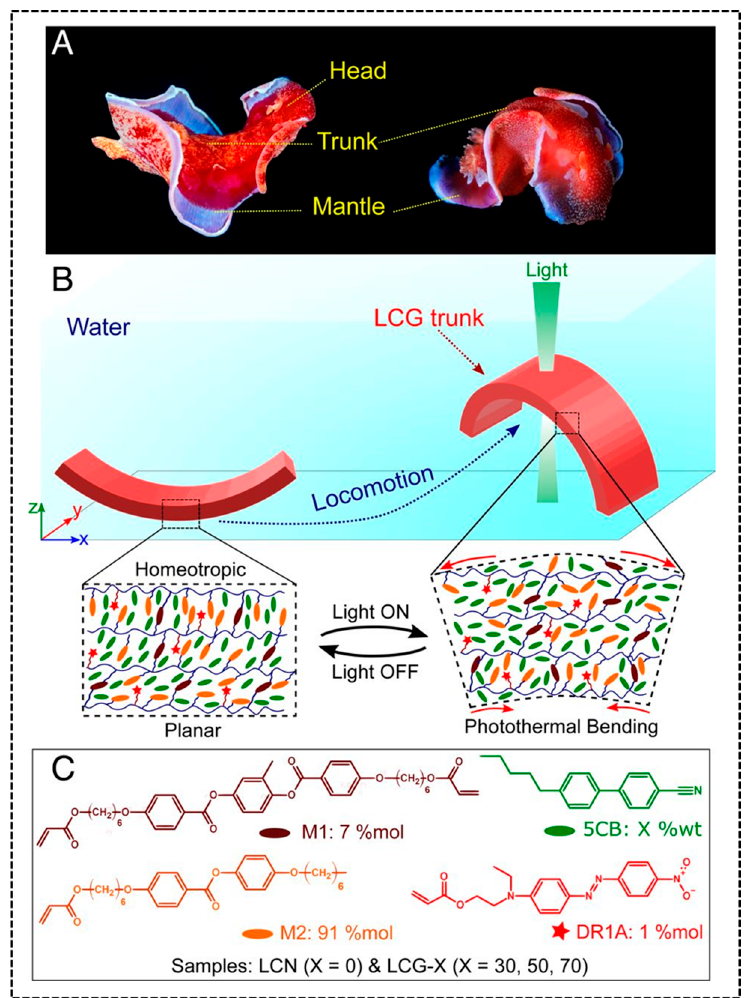
Figure 12. Shape morphing in a sea slug and artificial monolithic analogs from liquid crystal gels (LCGs). ( A ) An Hexabranchus sanguineus (Spanish dancer) swimming with the bending undulation of its central trunk. ( B ) Schematic view of an artificial analog of the Spanish dancer’s central trunk made from LCG constructs that move by repeating shape morphing. The relaxed state on the left side corresponds to a splay molecular alignment, while the bent state on the right side corresponds to the photothermally deformed LCG construct with disordered molecules. ( C ) The chemical structure of mesogenic monomers and the photothermal agent used to realize the light-fueled deformation of liquid crystalline networks (LCNs) and liquid crystalline gels (LCGs); X represents the amount of the 5CB added to the original LCN precursor mixture in weight percentage. Adapted with permission from Reference [81], National Academy of Sciences of the United States of America, 2020.